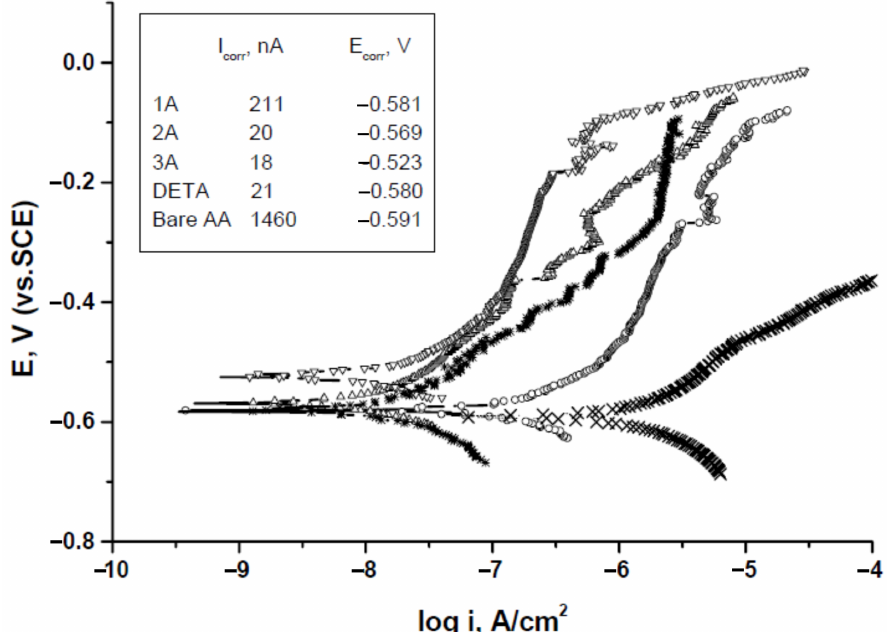
Figure 8. Potendiodynamic scans of 2024 T3 aluminum alloys where SNAP coatings were applied and prepared with several crosslinking agents (1A: 3-aminopropyltrimetoxysilane ( 2A: 3-(2-aminoethyl)aminopropyltrimethoxysilane ( ∆ ), 3A: 3-(trimethoxysilyl) propyldiethylene- triamine ( (cid:53) ), DETA: diethylenetriamine (*)) and bare AA 2024 T3 (x). Reprinted with permission from Ref. [24]. Copyright 2003,